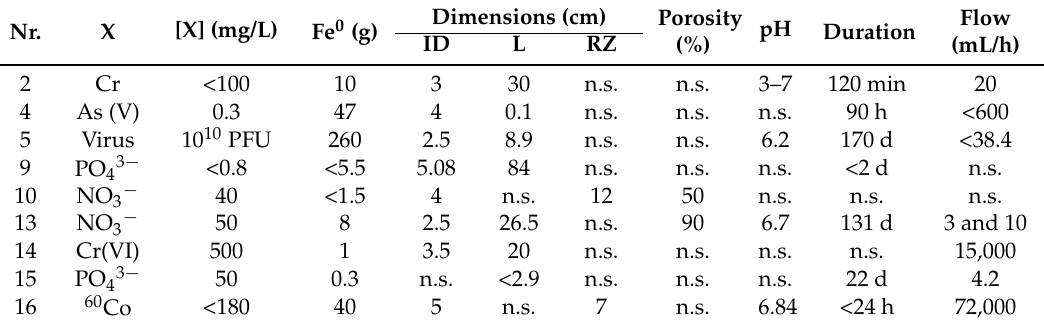
Table 4. Summary of some experimental conditions used for the column experiments in nine of the peer-reviewed articles using steel wool for contaminant removal. The numbers (Nr.) are related to relevant references as specified in Table 2. Point forming unit is abbreviated to: “PFU”. X stands for the used contaminant and [X] for its concentration. ID is the internal diameter of the column, L its length and RZ the thickness of the reactive zone (Fe 0 -bearing